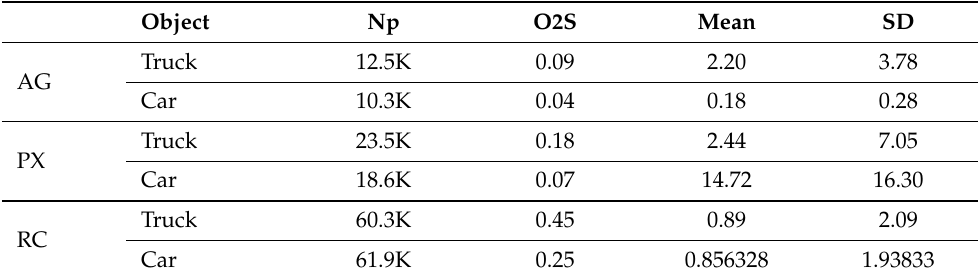
Table 8. Agisoft (AG), Pix4d (PX), and RealityCapture (RC) mean and standard deviation distances relative to the reference point cloud in millimeters for multi-objects scene.